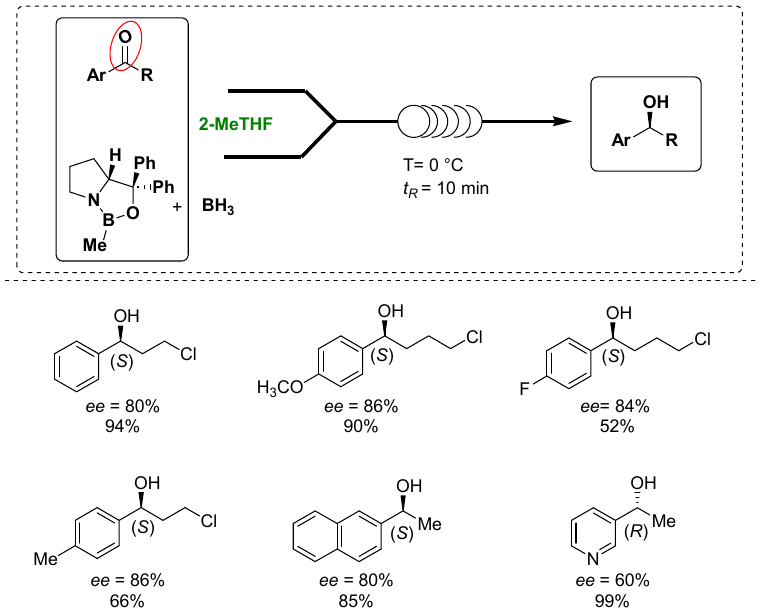
Figure 3. Luisi’s asymmetric reduction of ketones to alcohols under microfluidic conditions in 2- MeTHF.